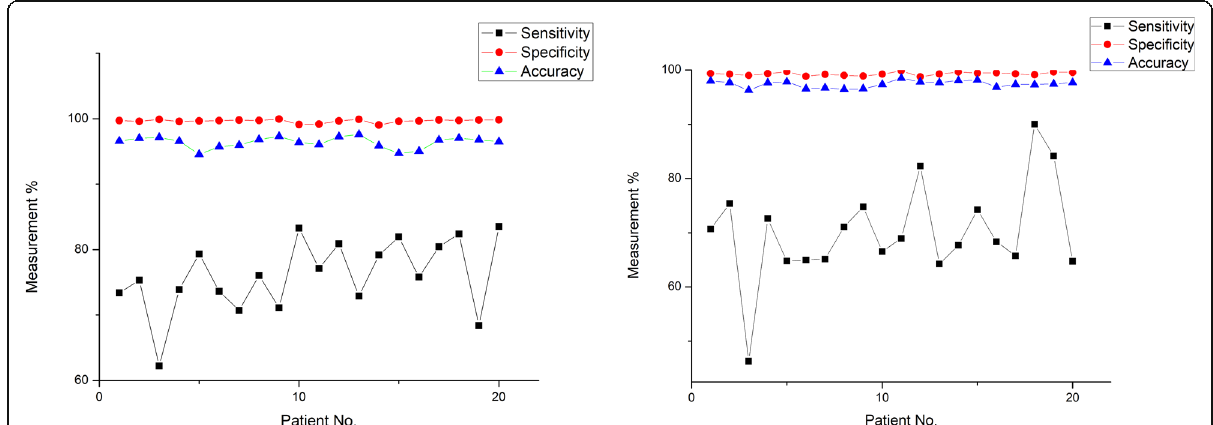
Fig. 7 Results of sensitivity, specificity and accuracy for CT dataset using the modified DRLSE for atrophy and normal subjects